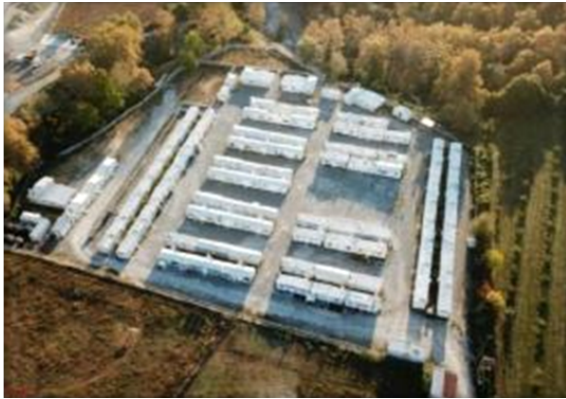
Figure 5. Kato Milia camp in Katerini, September 2020. Source: International Organization of Migration